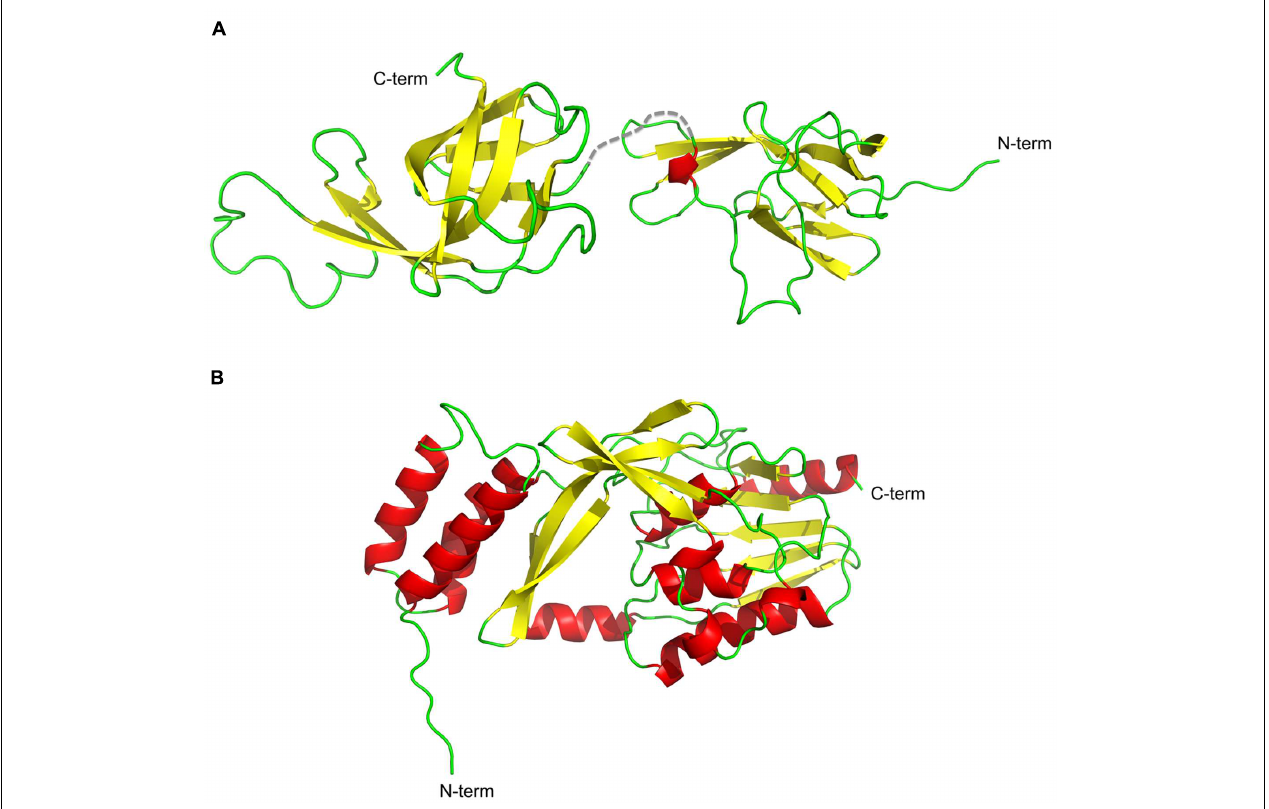
FIGURE 3 | Cartoon representation of the structures of NisI and Sa NSR. The structures of (A) NisI (PDB codes: 2N32 and 2N2E) and (B) Sa NSR (PDB code: 4Y68) are shown with the secondary elements color coded as red for helices, yellow for sheets and green for the loops. The figure was created with Pymol.